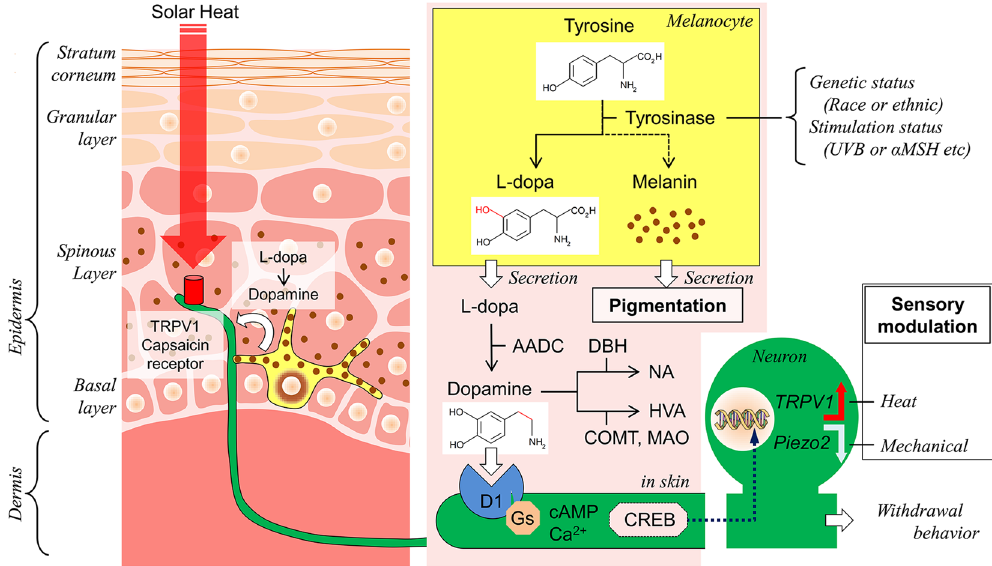
Figure 5. Mechanism of skin dopaminergic sensory modulation. The left schema represents dopaminergic signalling (white arrow) between nerve endings (green) and melanocytes (yellow) in structure of the epithelial skin. The right schema shows tyrosinase cascade in melanocytes, metabolism of L-dopa in extracellular space (pink) in the skin and presumed CREB-dependent gene modulation pathway from nerve endings to neuronal soma of primary sensory neurons, following dopaminergic D 1 receptor activation. Tyrosinase activity is different among races or ethnicity (genetic status) and environment (stimulation status). A red arrow with TRPV1 and a white arrow with Piezo2 indicate up-regulation and down regulation, respectively. TRPV1 and Piezo2 are not always co-expressed although we draw both in the same neuronal soma. AADC, Aromatic L-amino acid decarboxylase; α MSH, α -Melanocyte stimulating hormone; COMT, catechol-O- methyltransferase; DBH, dopamine- β -hydroxylase; MAO, monoamine oxidase A; HVA, homovanillic acid; UVB, ultraviolet